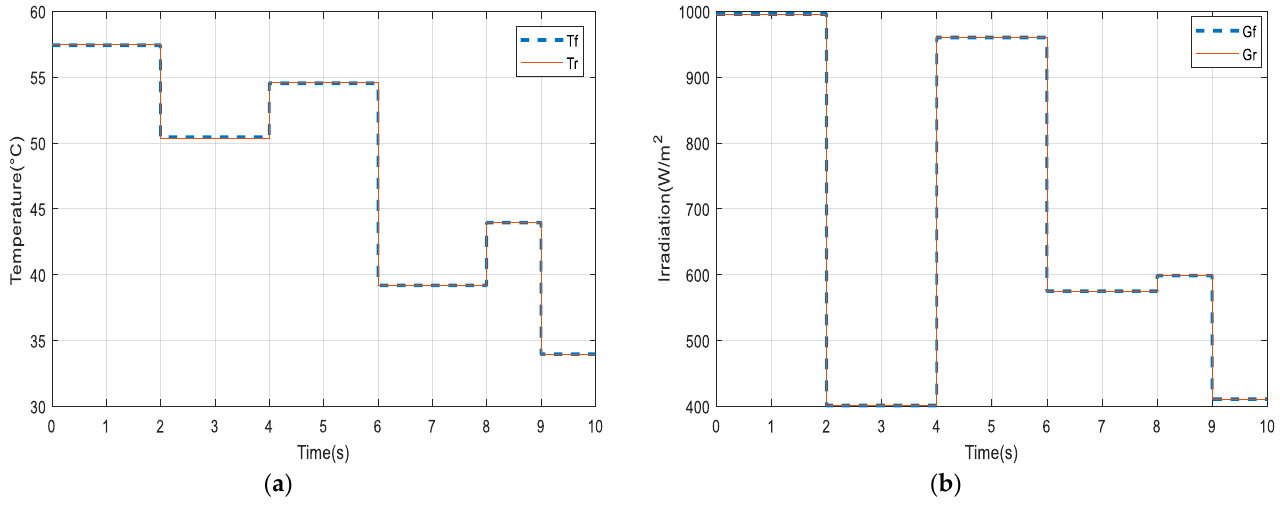
Figure 16. Forecasting results: ( a ) Temperature forecast, ( b ) Irradiation